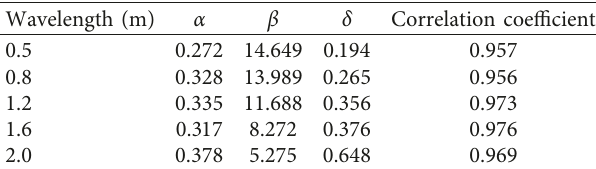
Figure 12: Fitting curve of siltstone damage under cyclic impact. Table 4: Fitting parameter values under different